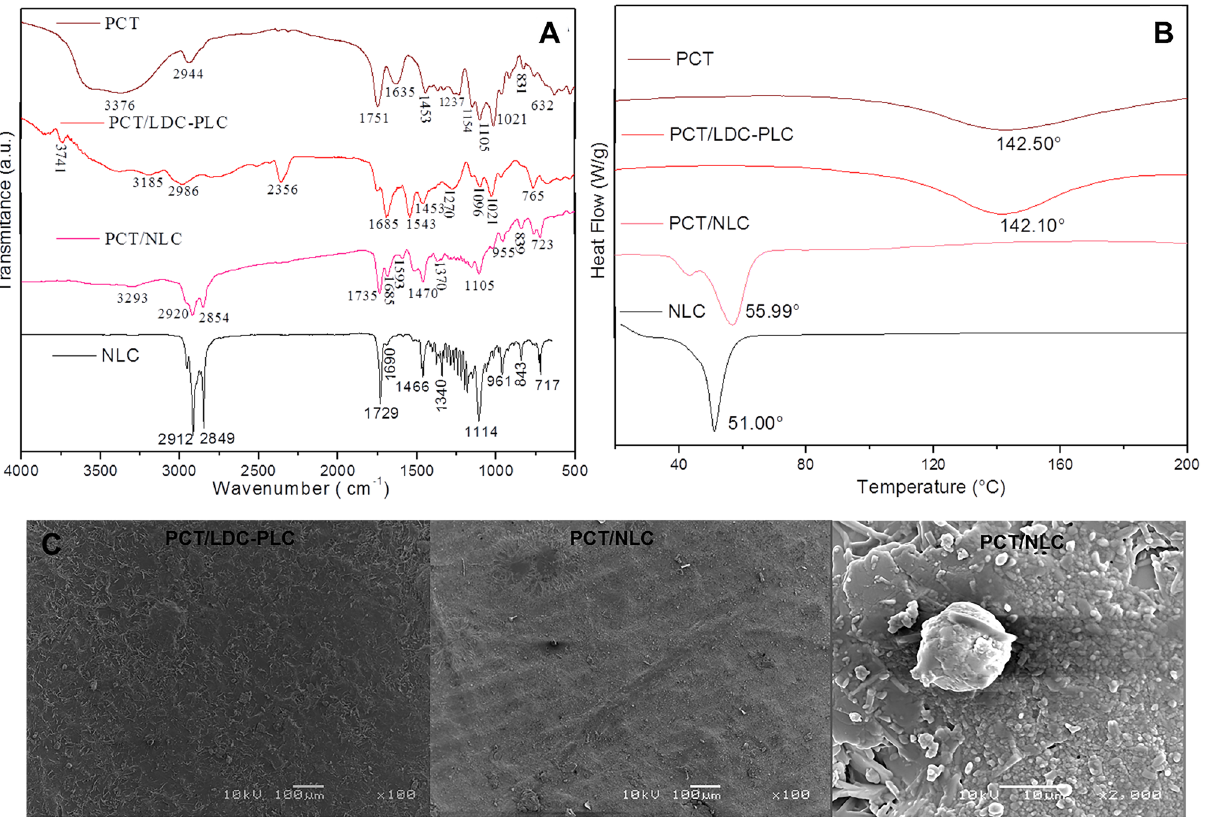
Figure 3. Structural characterization of pectin (PCT), control film (PCT/LDC–PLC) and hybrid (PCT/NLC) film and NLC loading 5% LDC–PLC, in terms of FTIR-ATR ( A ), DSC ( B ) and FE-SEM ( C ) techniques. The employed magnifications are displayed in the